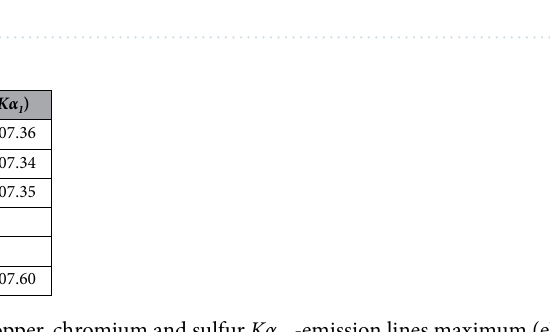
Table 2. Energy position of X-ray copper, chromium and sulfur Kα 1,2 - emission lines maximum (eV).